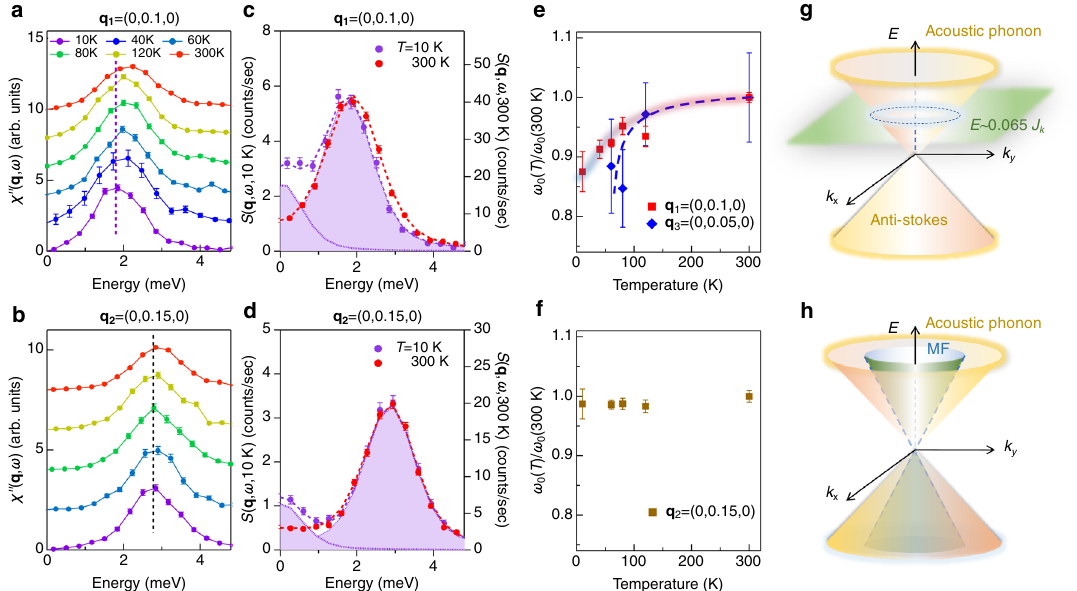
Fig. 4 Giant acoustic phonon softening. a , b Show the temperature-dependent χ 00ð q ; ω Þ at q 1 = (0, 0.1, 0) in reciprocal lattice units (r.l.u.), ω ~2 meV and q 2 = (0, 0.15, 0) r.l.u., ω ~ 3 meV, respectively. c direct comparison of the IXS raw data, S ð q 1 ; ω Þ ; at T = 10 and 300 K. d shows the same plot as ( c ) but at q 2 . There is an apparent phonon softening at q 1 , while at q 2 , the effect is negligible. e , f The relative peak shift at q 1 , q 2 and q 3 . The ~13% phonon softening at q 1 (red squares in e ) corresponds to a ~0.3 meV phonon peak shift. This value is as large as some well-known electron – phonon coupled systems 10 . The blue diamonds in e represent the relative peak shifts at q 3 = (0,0.05,0) that show even larger softening-effect (~15% at 60 K), whereas q 2 displays negligible change as shown in ( f ). This acoustic phonon anomaly, together with the spectral enhancement discussed in Fig. 3, present a full picture of the FPC in α - RuCl 3 . g , h Schematically show two phonon coupling mechanisms. g The fl atband of the Z 2 fl ux mode intercepts the acoustic phonon near ω ~0.065 J K . h The nearly identical linear dispersion of the itinerant MF and the acoustic phonon at q ! 0 causes a phonon renormalization at low temperature. The error bars in a – d represent one standard deviation assuming Poisson counting statistics. The error bars in e , f denote the 2 σ returned from the fi